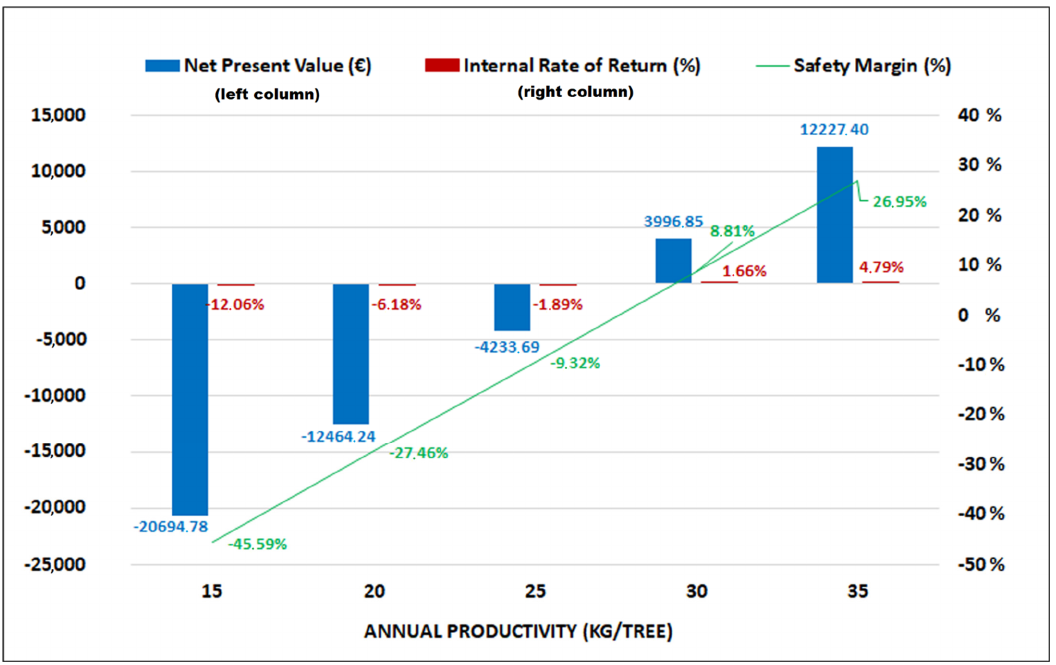
Figure 2. Financial parameters of acorn chain (sensitivity analysis on flour price).